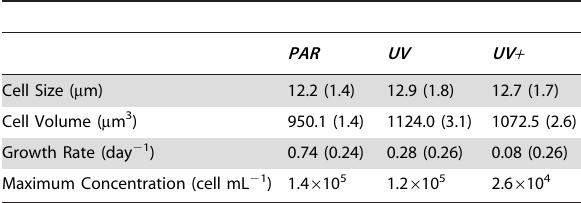
Table 2. Characteristics of Thalassiosira weissflogii cultures grown in F/2 media under 3 light